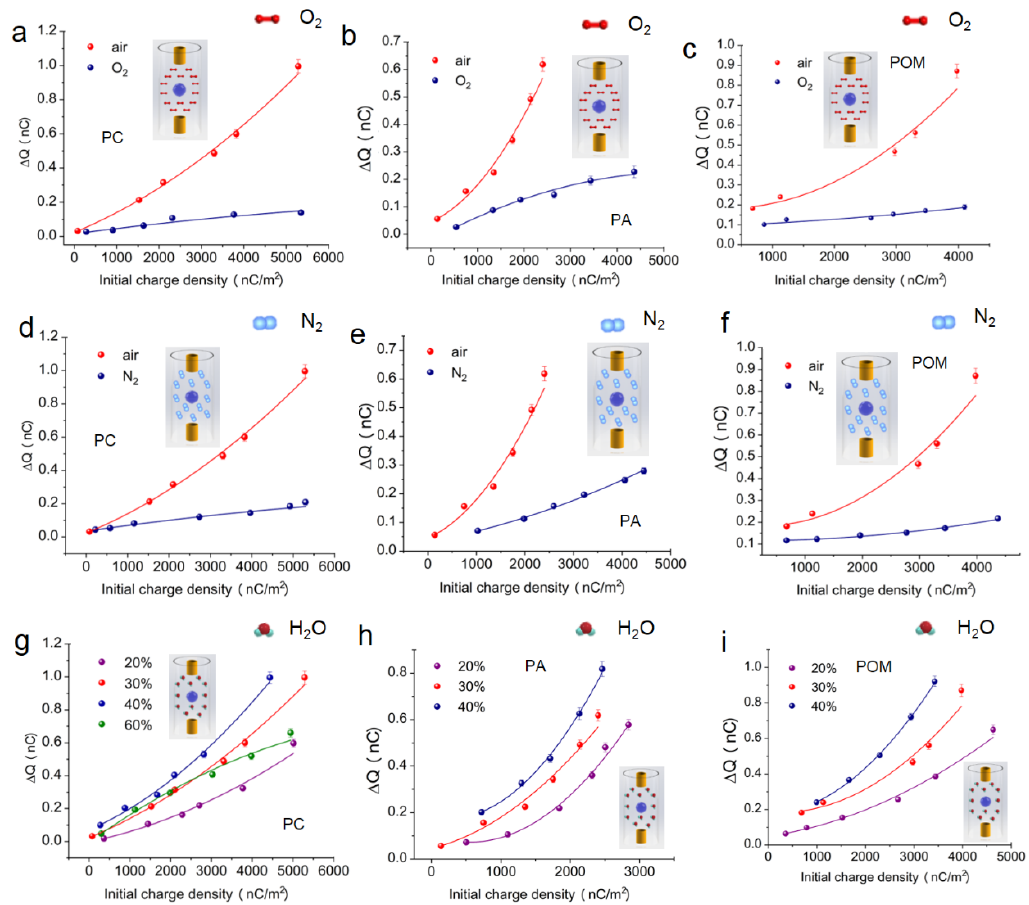
Figure 5. The difference between gas–polymer contact electrification in the non-polar-gas-rich atmosphere and polar-gas-rich atmosphere. ( a – c ) The effect of the non-polar-gas-rich atmosphere (O 2 ) on gas–PC, gas–PA, and gas–POM contact electrification. ( d – f ) The effect of the non-polar-gas-rich atmosphere (N 2 ) on gas–PC, gas–PA, and gas–POM contact electrification. ( g – i ) The effect of the polar-gas-rich atmosphere (H 2 O) on gas–PC, gas–PA, and gas–POM contact electrification. The concentration is 20%, 30%, 40%, 60%.